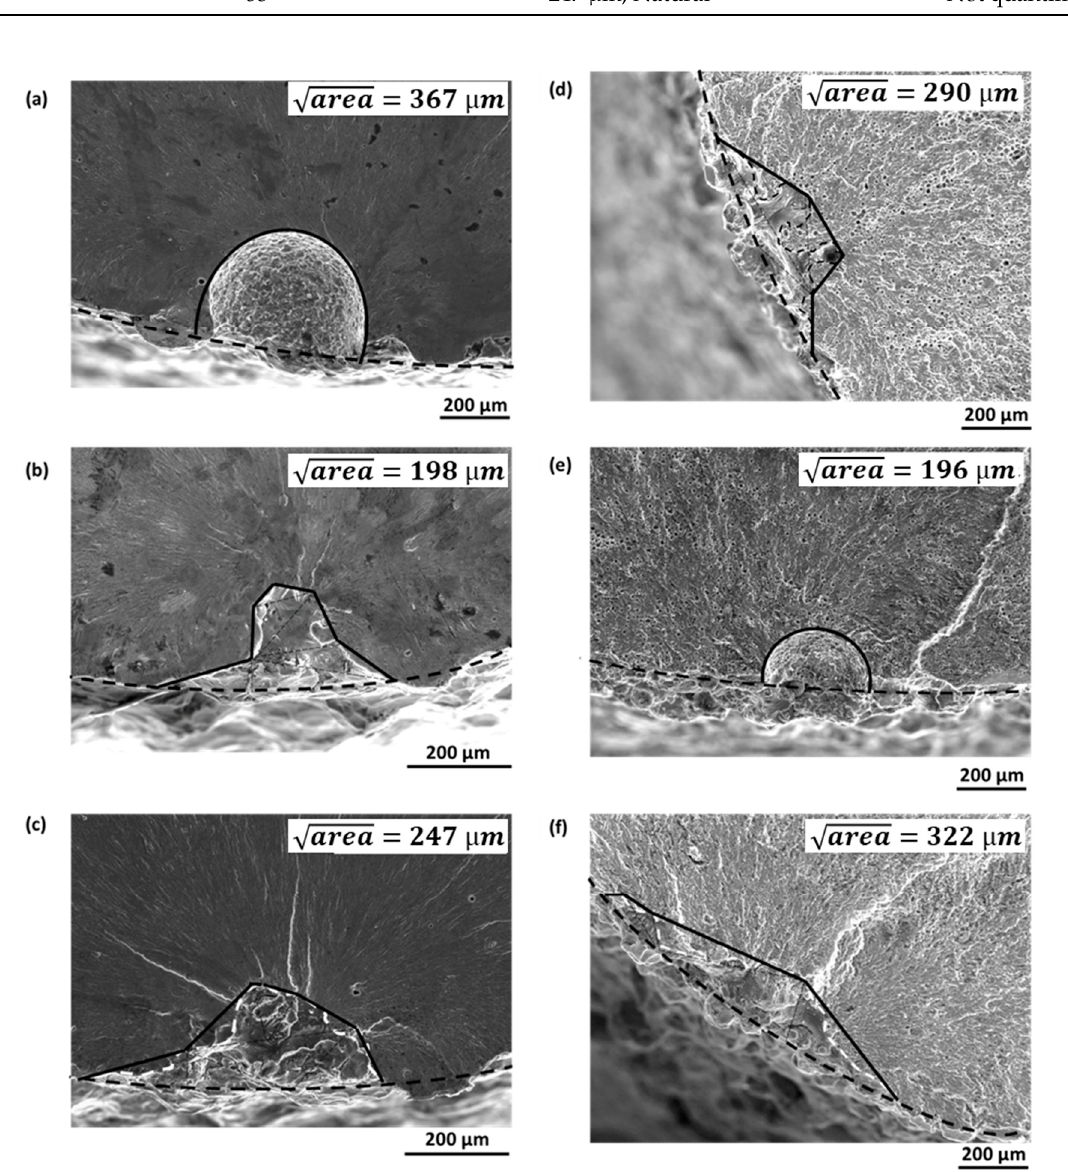
Figure 11. Data presented on Table 4. SEM observations of initiation sites for AB-Z ( a – c ) and AB-Z-T6 ( d – f ) specimen. For non-T6 cases: ( a ) direct rupture at 30 MPa after 800,000 cycles, ( b , c ) fatigue limit at 1 million cycles of 60 and 53 MPa, respectively. For T6 cases: fatigue limits at 1 million cycles of 37 MPa, 59MPa and 71 MPa, respectively, for ( d – f